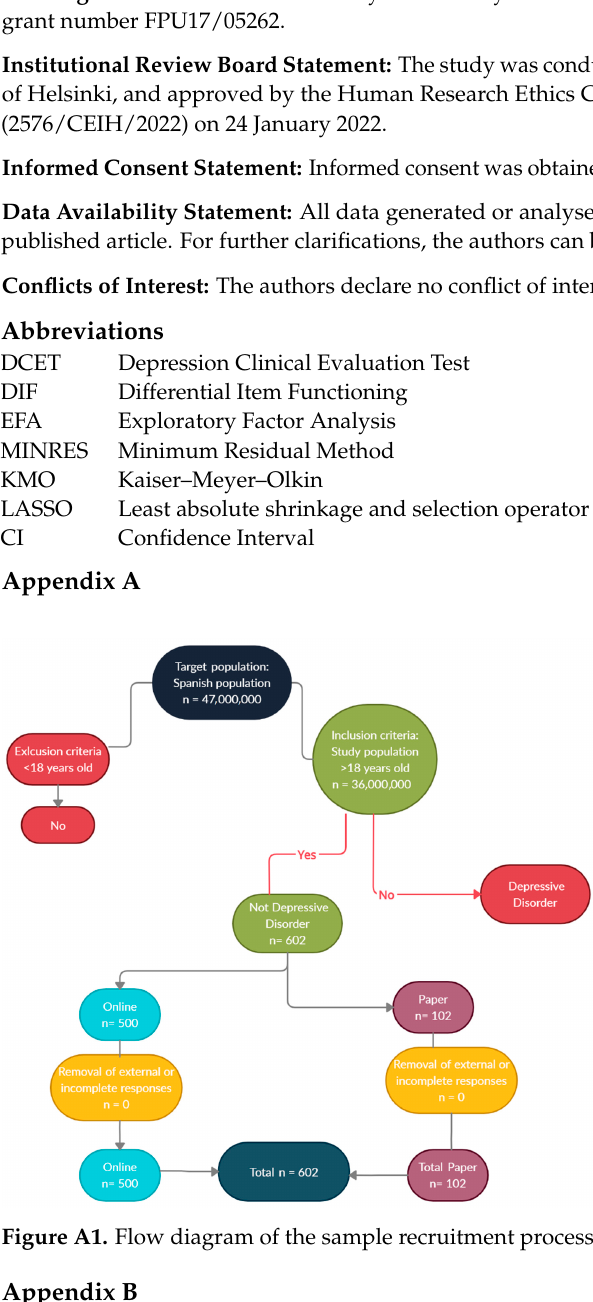
Table A1. Saturations and factorial structure of the DCET items at the moment “month” (N = 602).